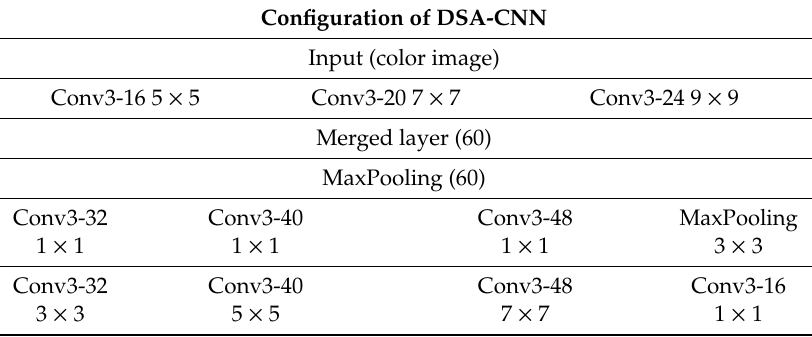
Table 1. The configuration of